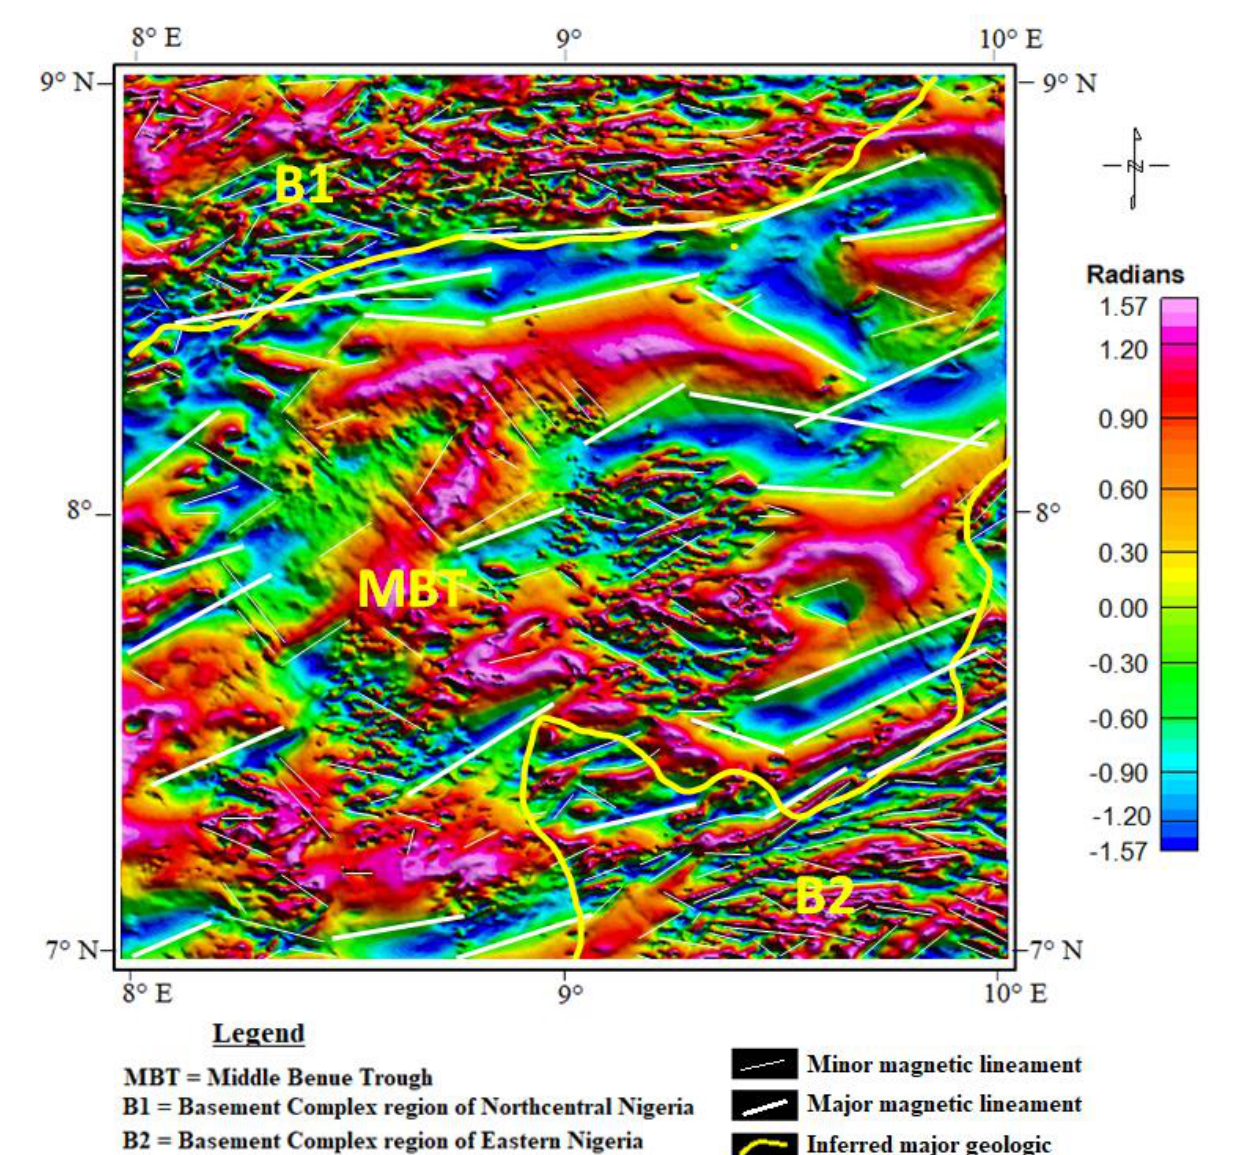
Figure 7. TDR map of the study area.